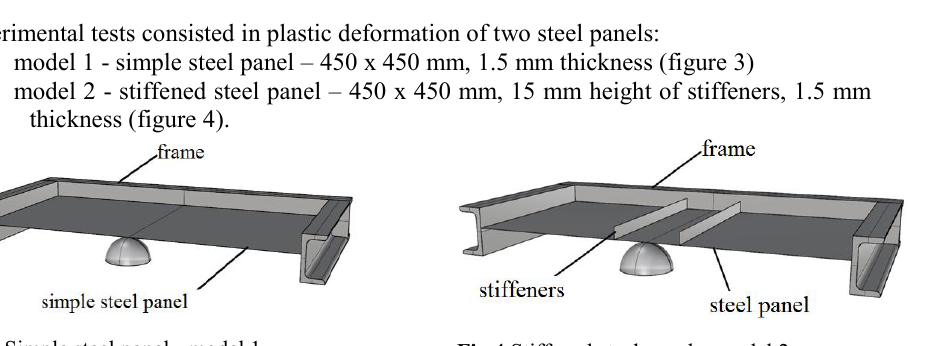
Fig.3 Simple steel panel - model 1 Fig.4 Stiffened steel panel – model